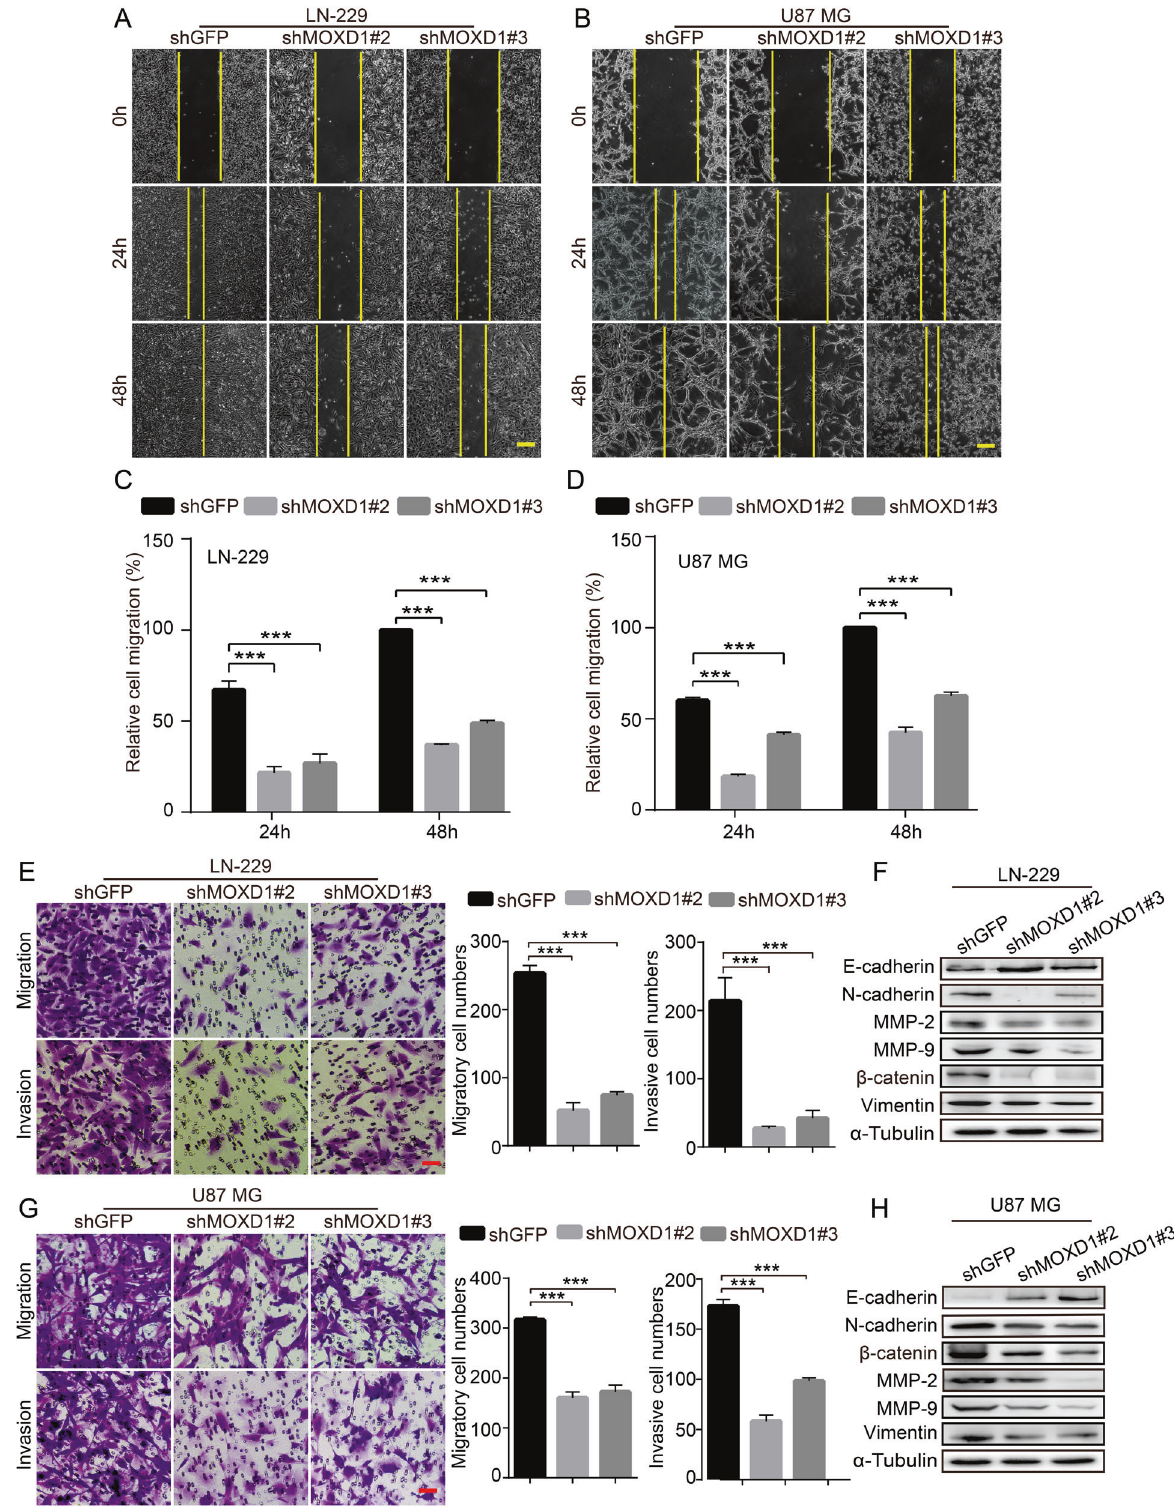
Fig. 4 Blocking MOXD1 prevents migration and invasion of GBM cells. A , B Scratch test was used to detect cell migration distance after MOXD1 knockdown cells. C , D Statistics of migration distance after MOXD1 knockdown cells. E , F Migration and invasion assays were performed to detect the effect of MOXD1 knockdown on LN-229 and U87 MG cells. F , H EMT-related proteins are detected in MOXD1 knockdown cells.